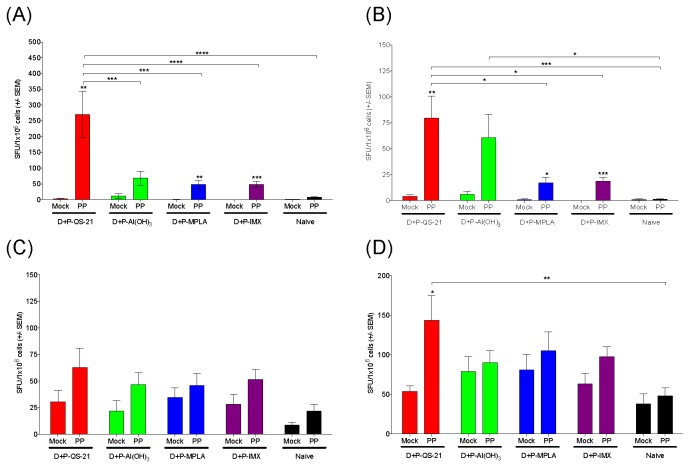
Env-specific cellular immune responses in splenocytes from mice immunized with DP6-001 and candidate adjuvants.Spleens were harvested from immunized C57Bl/6 wild type mice at termination 7 days after the final protein boost. Cells were cultured for 18 hours either receiving the stimulation of a truncated HIV-1 gp120 Clade B peptide pool (‘PP’) or media (‘mock’). Cytokine spot-forming units (SFU) per million splenocytes were visualized with a CTL Imager and analyzed with Immunospot™ software. Splenocyte production of gp120-specific Th1 cytokines (A) IFNγ and (B) IL-2, and gp120- specific Th2 cytokines (C) IL-4 and (D) IL-6 were measured. Statistical analysis of peptide stimulation over mock stimulation was calculated by Student’s t-test. Significant values (*: p < 0.05) are represented above error bars. Statistical differences in peptide stimulation between adjuvant groups were calculated by a Two-way ANOVA and Bonferroni post-test (*: p < 0.05, **: p < 0.01, ***: p < 0.001) (IMX = ISCOMATRIX™ adjuvant)..